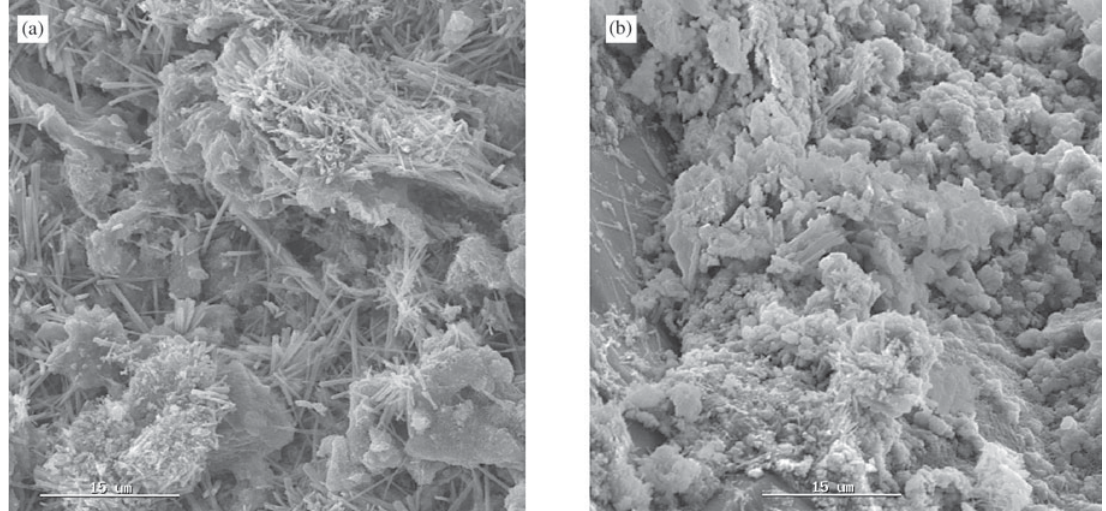
Figure 3. Photomicrographs of Concrete: a) region of formation of ettringite; b) portlandite and calcium